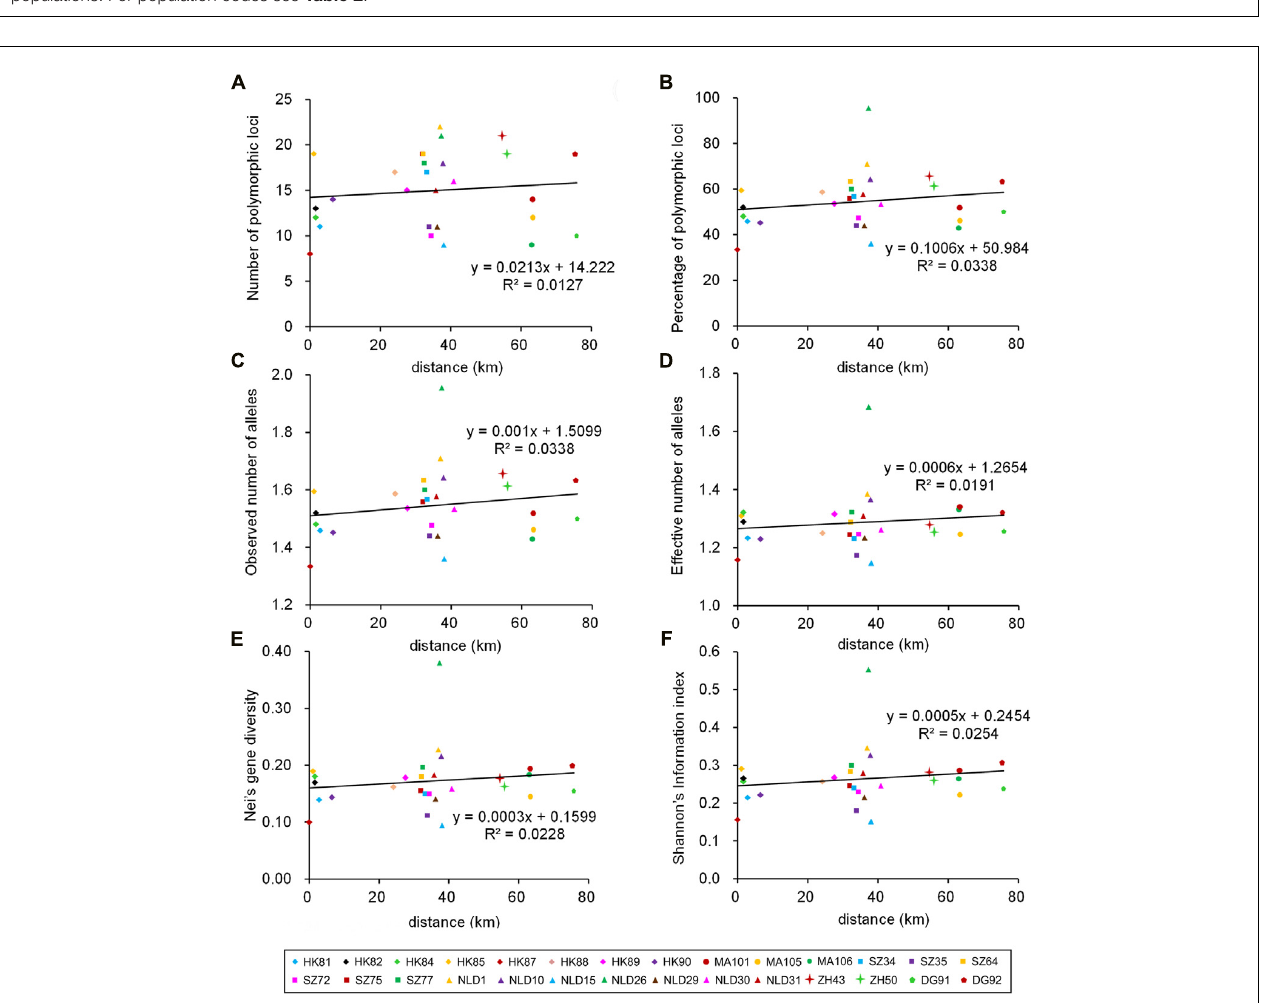
FIGURE 3 | Linear regressions between number of polymorphic loci (A), percentage of polymorphic loci (B), observed number of alleles (C), effective number of alleles (D), Nei’s gene diversity (E), and Shannon’s information index (F) and the distance of sites from Hong Kong Zoological and Botanical Gardens and calculated over 39 variable loci (Pearson, P >